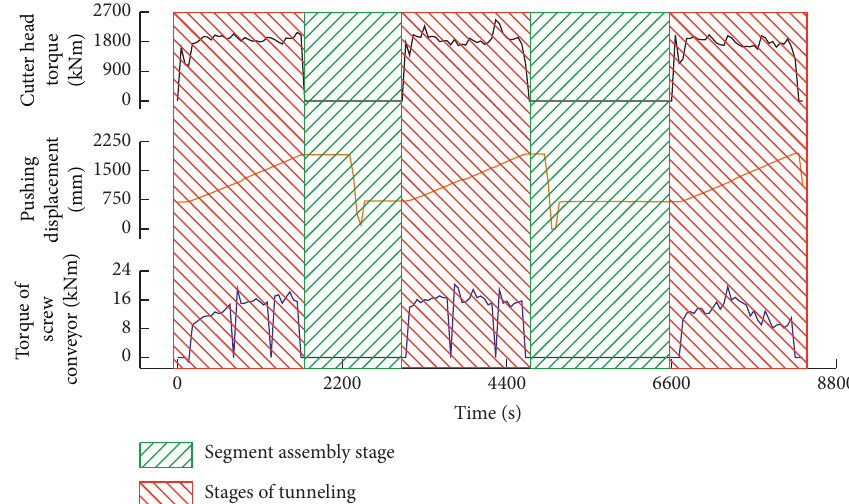
Figure 4: Shield construction data of two-stage circulation.